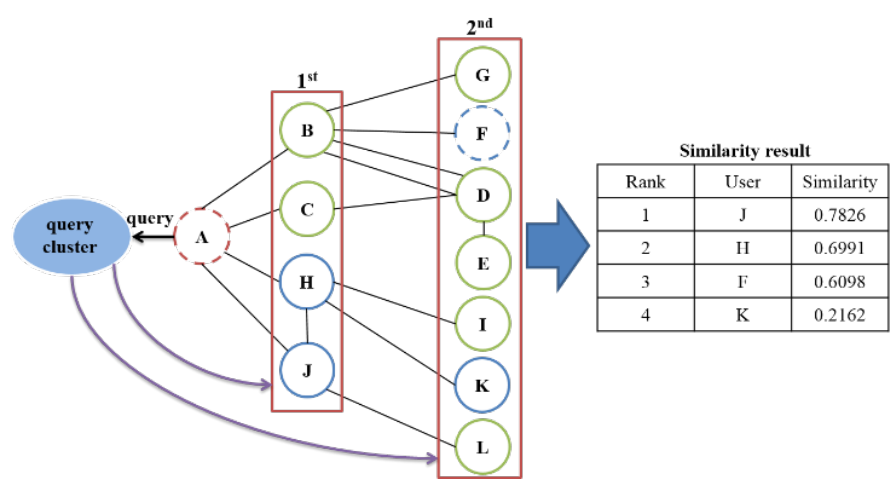
Figure 6. Calculated similarity results for a question and user profiles.